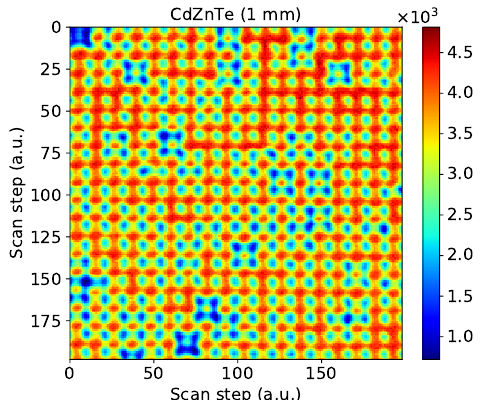
Figure 8. Sensitivity maps of a pixel area covering 1 mm 2 within a CdZnTe sensor with 55 µm pixel pitch and a thickness of 1 mm. The raster scans performed with a step of 5 µm with the energy threshold set at 4.5 keV.